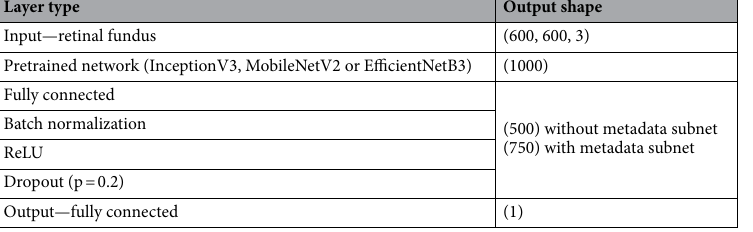
Table 5. Modified architecture of the main network.